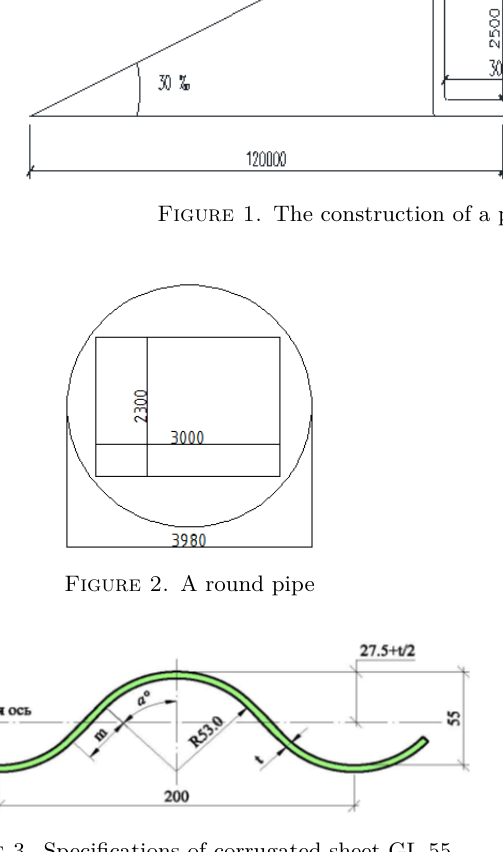
Figure 3. Specifications of corrugated sheet GL 55